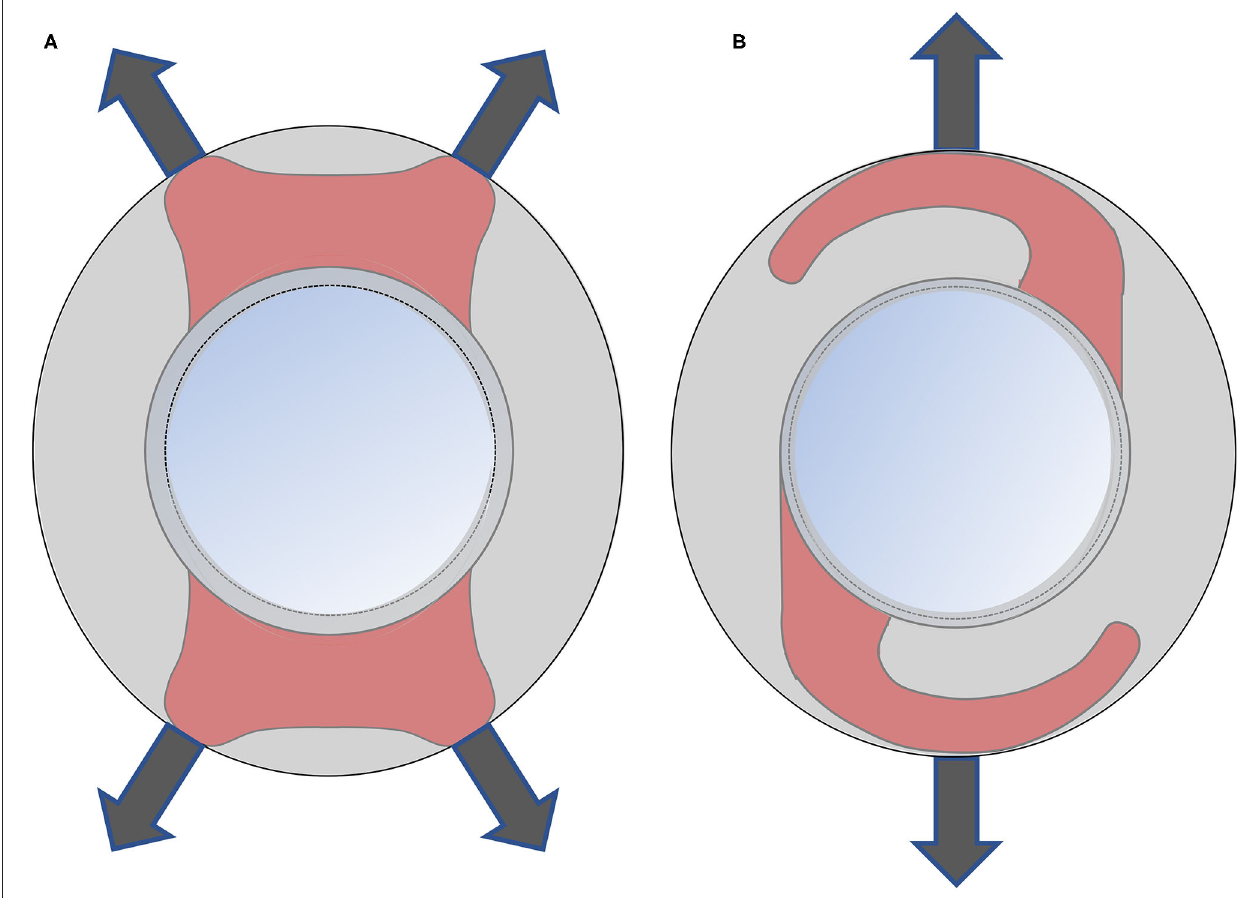
FIGURE 3 | Comparison of Plate-haptics and C-loop IOL. The gray area is the capsule. The red area is the area of haptics covered by the capsule. (A) The Plate-haptics IOLs can get great support from the capsular bag through the four corners and more area of haptics can be covered by capsule compared to C-loop IOLs. (B) The C-loop IOLs has only two support points against capsule and there is a large gap between the optic and haptics.